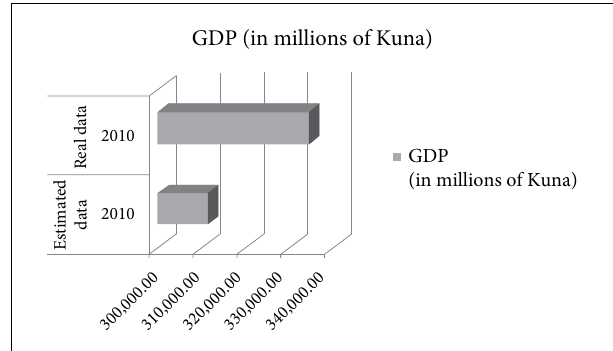
Fig. 6. Comparative review of simulated and actual GDp for 2010 at the rate of inflation of 1.1%. Source: autors calculation